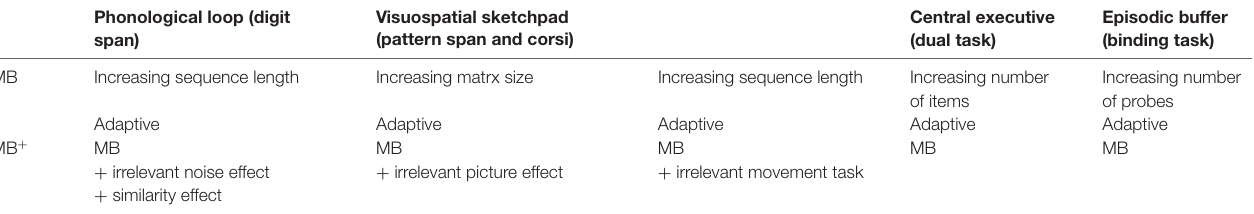
TABLE 1 | Representation of training tasks according to each working memory (WM) component of the multicomponent model (Baddeley, 2012) and levels of difficulty for the MB and MB + WM